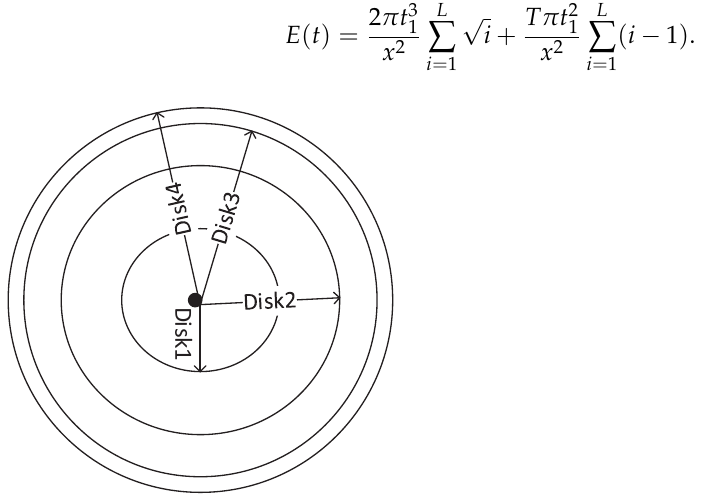
Figure 5. Disks Formation for